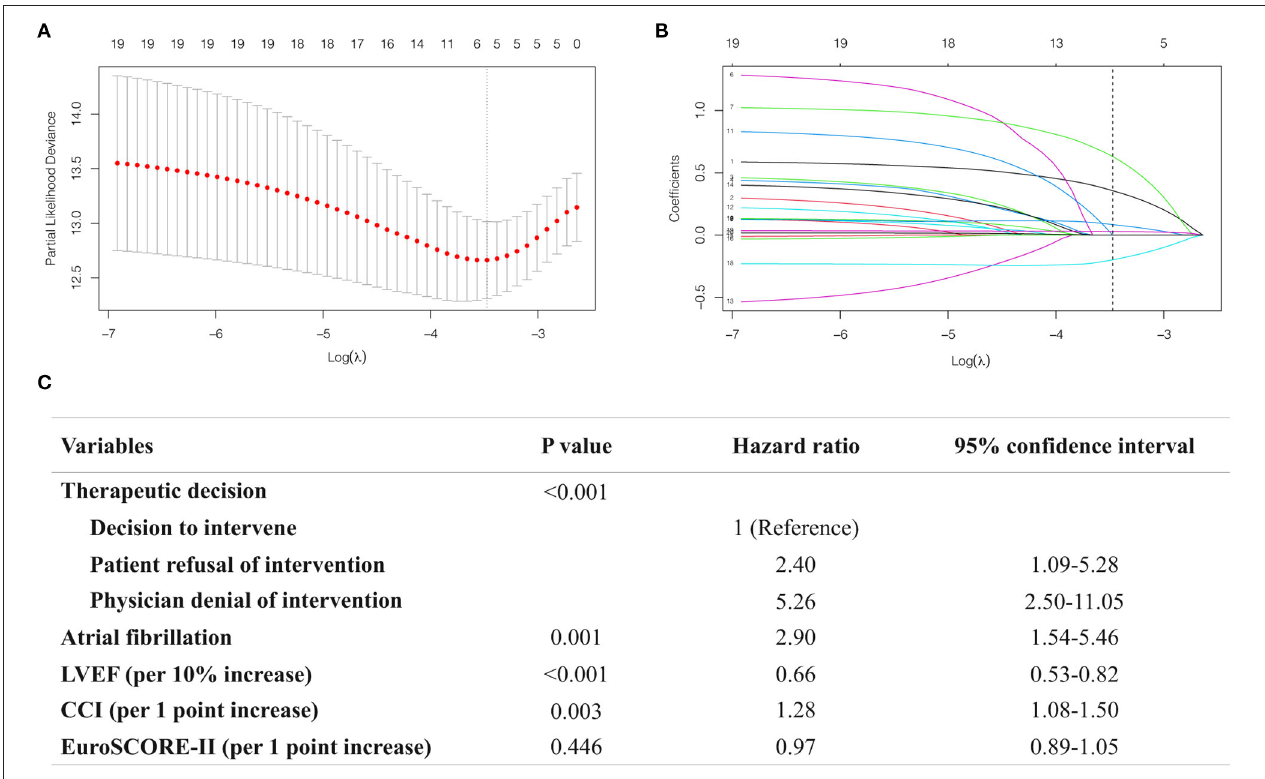
FIGURE 3 | Analysis of the predictors of 12-month mortality using LASSO-penalized Cox regression model. (A) The plot showing the deviance values of the LASSO model as a function of the tuning parameter λ . The optimal λ is the value that minimizes the deviance curve (dashed line). (B) Trace plot showing non-zero model coefficients as a function of the tuning parameter λ . As the λ increases, LASSO sets various coefficients to zero, thus removing them from the model. When λ corresponds to the minimum-deviance (dashed line), five variables are selected (C)